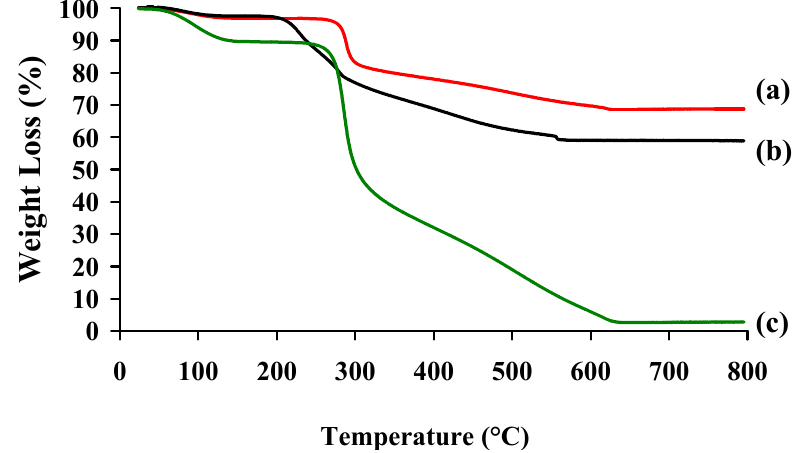
Figure 6. TGA profiles ( a ) CS-HA PEC complex, ( b ) HA and ( c ) CS.